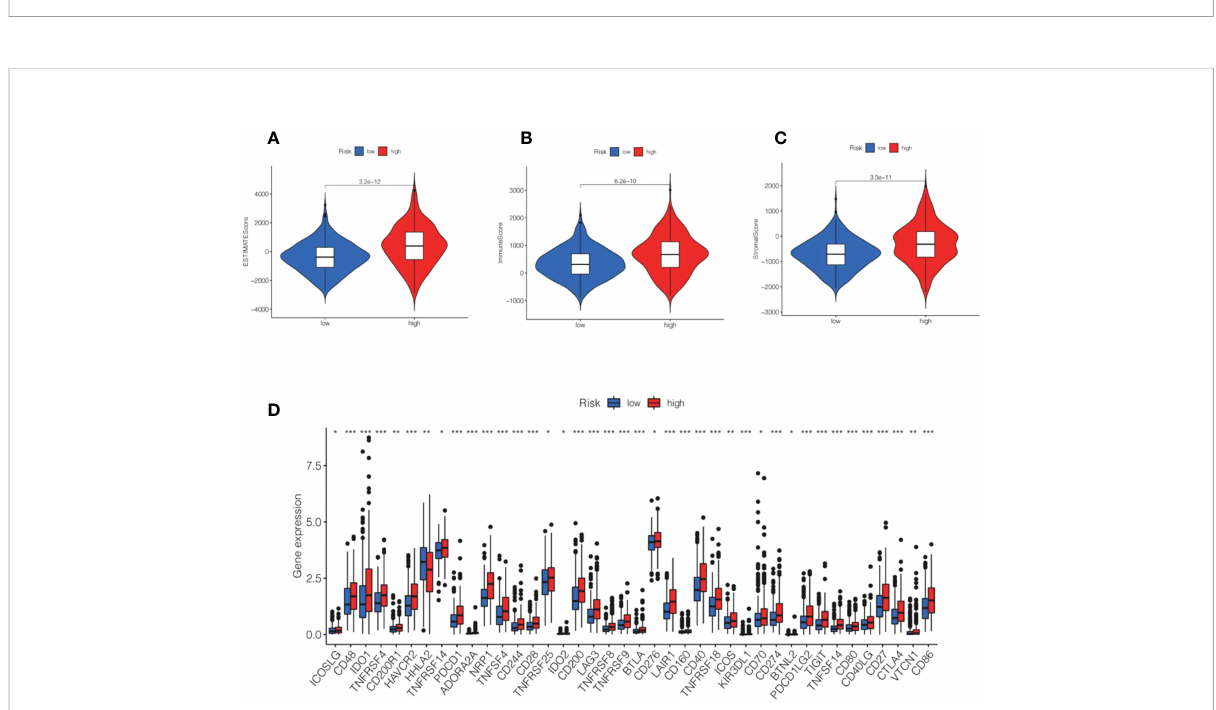
FIGURE 11 Correlation between ESTIMATE and immune checkpoint and risk score. (A – C) Violin shows the relationship between ESTIMATE and different subgroups. (D) Box plot displaying the correlation between the risk score and immune checkpoint.*P<0.05, **P<0.01, ***P<0.001.